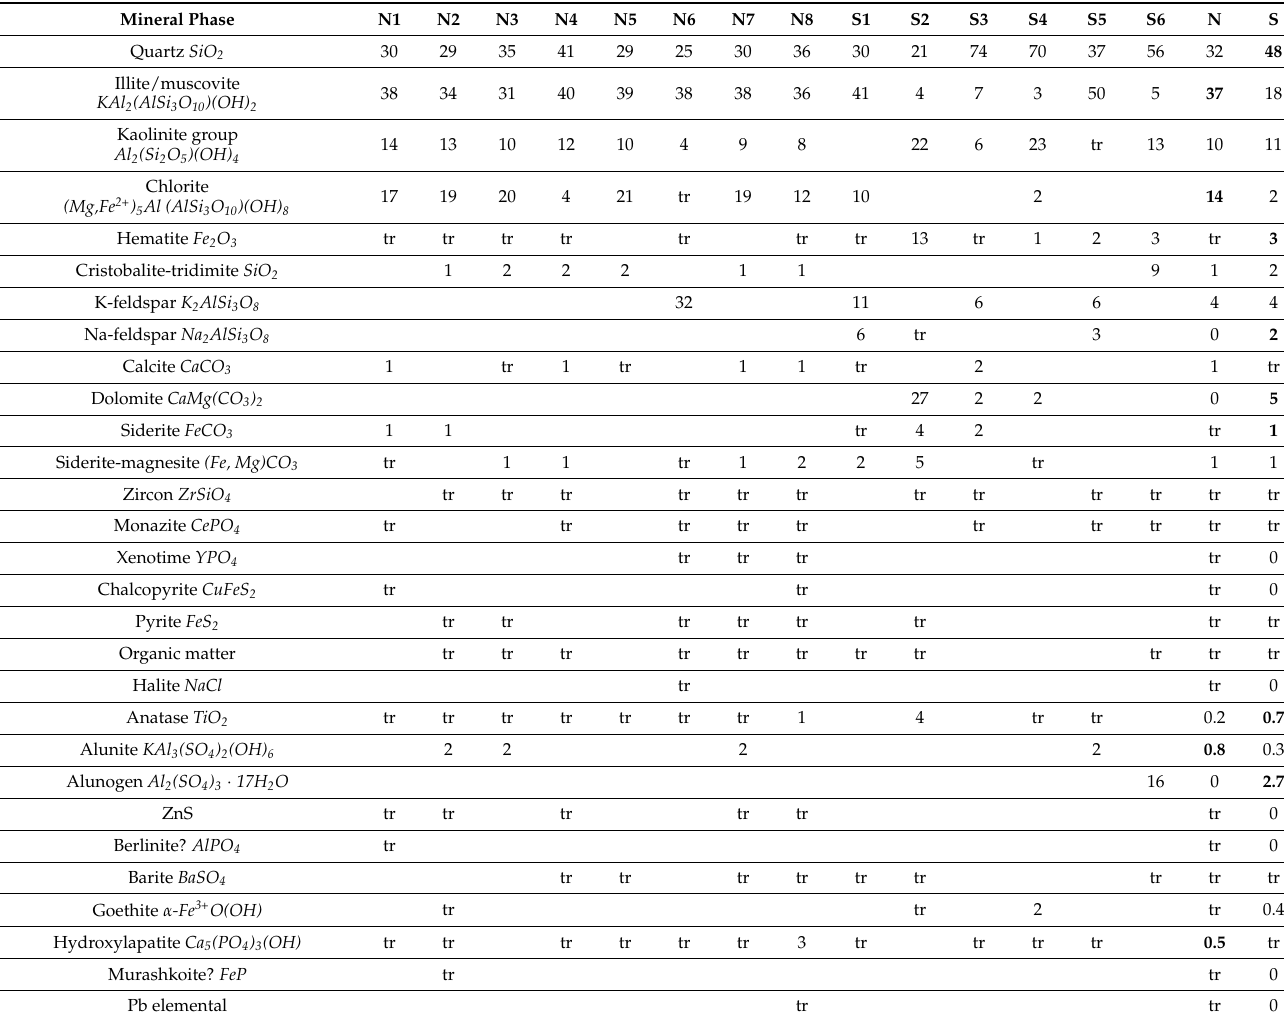
Table 2. Mineral compositions of the gangue-rocks samples from the northern (N1–N8) and southern (S1–S6) parts of the Jas-Mos mining area. Averaged content of mineral phases of the northern (N) and southern (S) samples is calculated. Higher values are shown in bold.